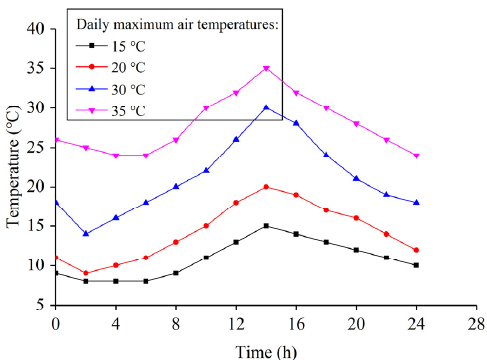
Figure 8. Daily variations of temperature for four different maximum temperatures. Table 6. Prediction of modified and unmodified rut depths and their